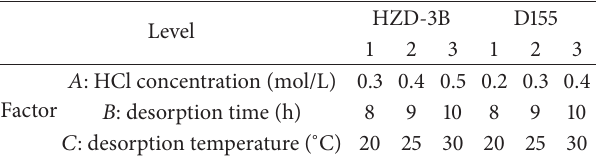
Table 2: Factors and levels in 𝐿 9 (3 4 ) orthogonal array test for HZD- 3B and D155